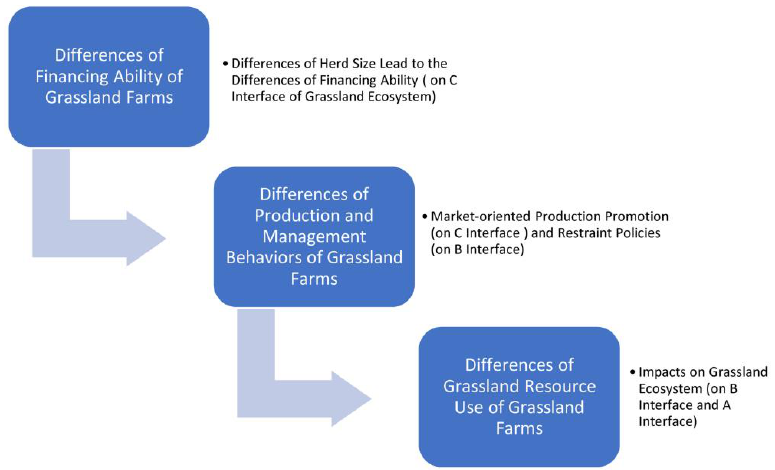
Figure 3. Differentiation mechanism for grassland resource use behavior of farms.